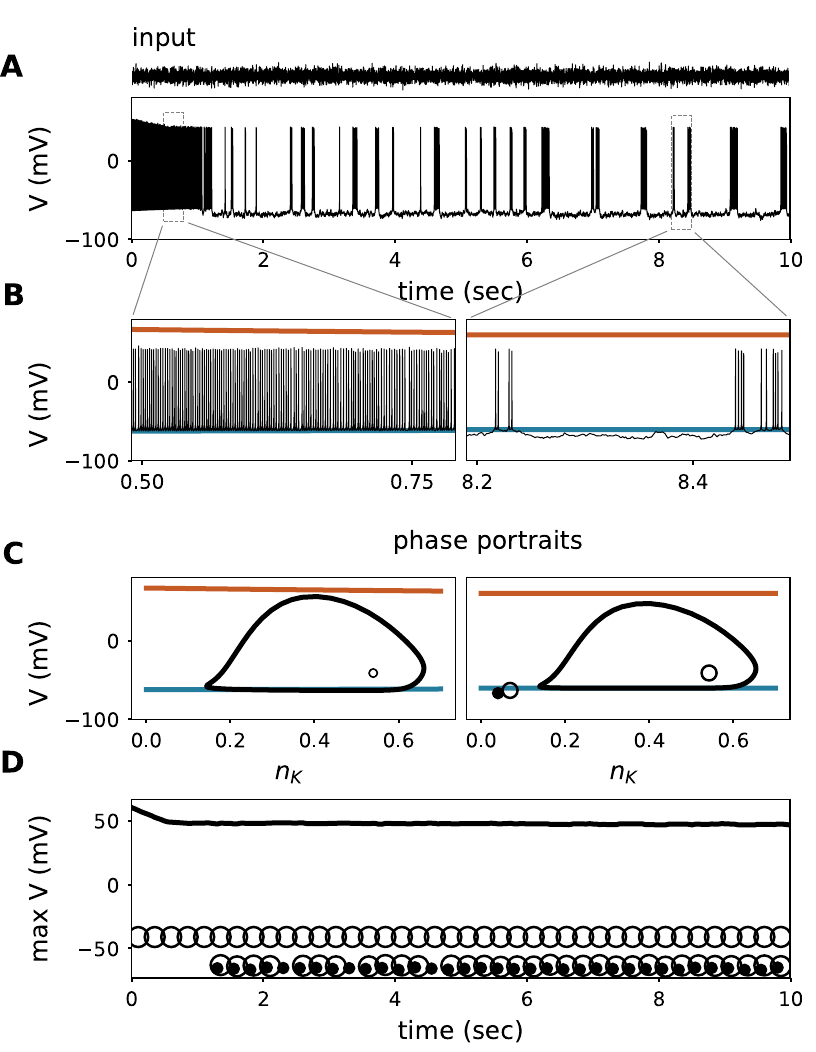
Fig 2. Response of the model to a step current with colored noise filtered at 500Hz (mean input is 1 μA / cm 2 and standard deviation 1.05 μA / cm 2 , shown above). A . Voltage trace (membrane potential) of the model responding to a noisy step current (Top of panel). B . Zoom of the voltage trace from panel A at the beginning and towards the end of stimulation showing the evolution of the reversal potentials for sodium (orange) and potassium (blue), as in Fig 1. C . Phase portraits of the steady state of the fast spike generating sub-system, when imposing the average reversal potentials for sodium (orange) and potassium (blue) of panel B as parameters. Vertical axes show the voltage and the horizontal axes show the potassium current gating-variable ( n K ). Empty dots are the unstable nodes, filled dots the stable nodes, and the orbits are stable limit cycles. D . Evolution of the maximum voltage of the system attractors. Empty dots represent the unstable nodes, filled dots the stable nodes, and the black line denotes the maximum voltage of the stable limit cycles (action potential peak). additional stable fixed point (i.e., a stable voltage) appears in parallel to the spiking mode for the same size of input current; the system becomes bistable. Which of the two attractors (regu- lar spiking or a fixed voltage) the system converges to depends on the initial conditions and/or noise in the system. In Fig 1, initial conditions are such that the neuron keeps up regular spik- ing because concentration changes are not substantial enough to reach the switch in spiking dynamics (the emergence of an additional fixed point attractor). When ionic concentration changes are substantial enough they reach the switching point, and the system displays bistable